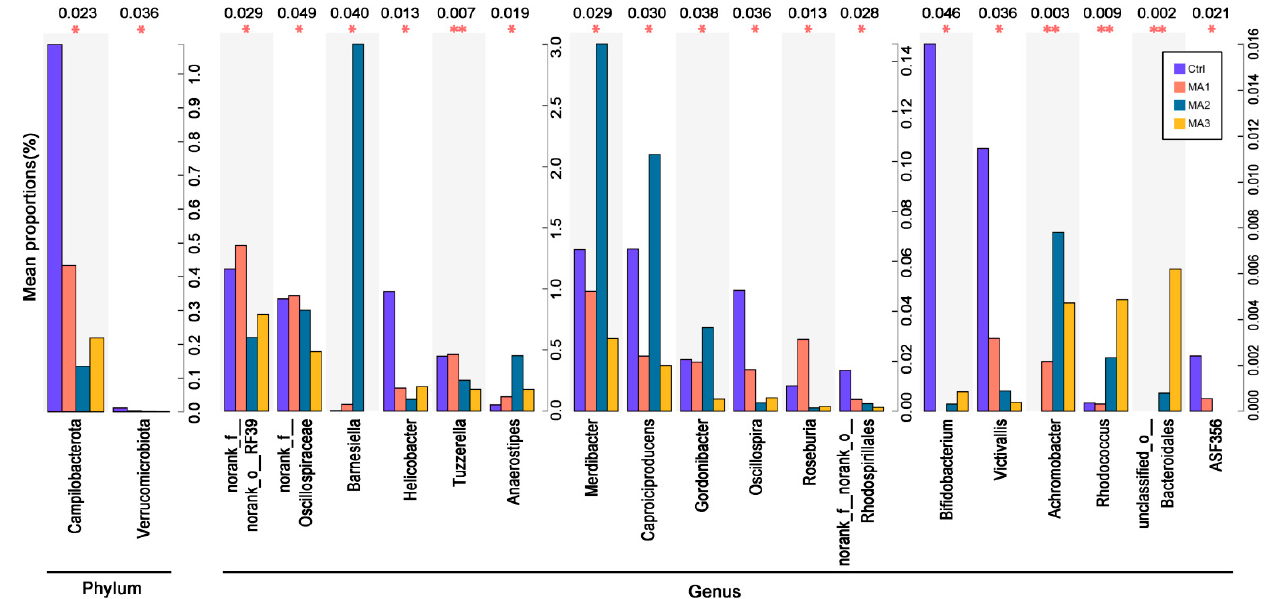
Figure 4. Different species between dietary treatments at the phylum and genus level in the ce- cal microbiota of broilers. Ctrl: the control group fed the basal diets; MA 1, 2, 3: the experimental groups fed the basal diets supplemented with 4, 8, and 12 g/kg of bio-fermented malic acid, respectively. * means significant differences between groups ( p < 0.05). ** means significant differences between groups ( p < 0.01).